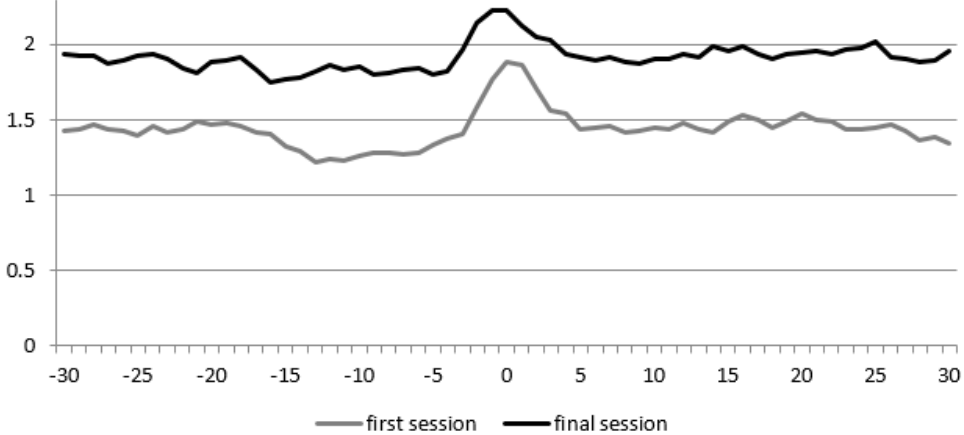
Figure 2. Diagonal Cross-Recurrence Profile (DCRP) of participant 1. The X-axis displays the delay in steps of 0.5 s, and the Y-axis the recurrence rate (i.e., the proportion of accurate